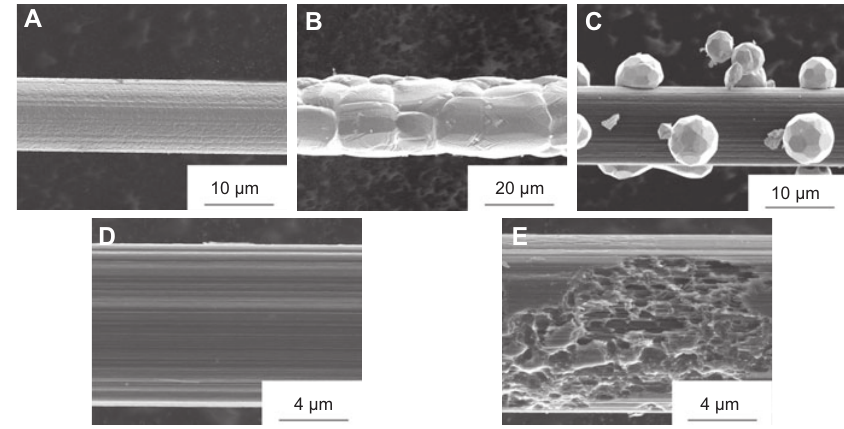
Figure 6 Morphological change of the surface of a monofi lament composite. (A) Ni is uniformly plated on a HM fi ber. (B) Grain growth of plated Ni is observed. (C) The plated Ni forms grains by surface tension. (D) Typical surface of HM fi ber. Ni was removed after heat treatment at 1100 ° C for 9 h. Reaction is hardly observed. (E) Reacted parts are rarely observed, but they are not deep pits.